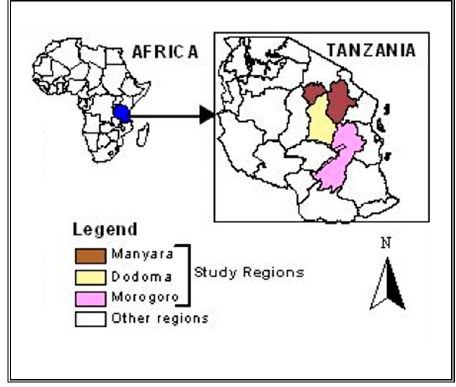
Figure 1. Map of Tanzania showing study regions. Table 1. Sampling plan for physical disturbance study.